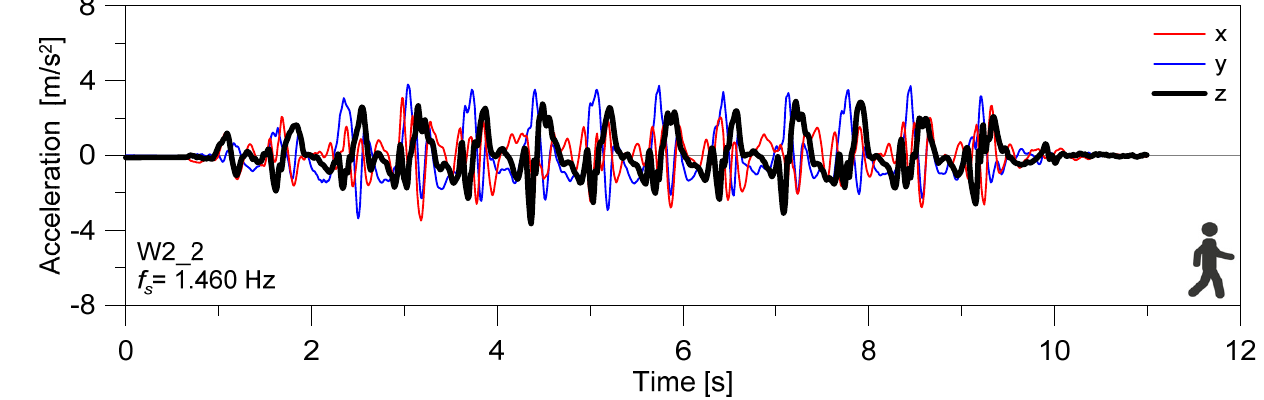
Figure 8. Example of experimental body CoM accelerations in time (W2 selection) for the volunteer moving on SLAB#1.